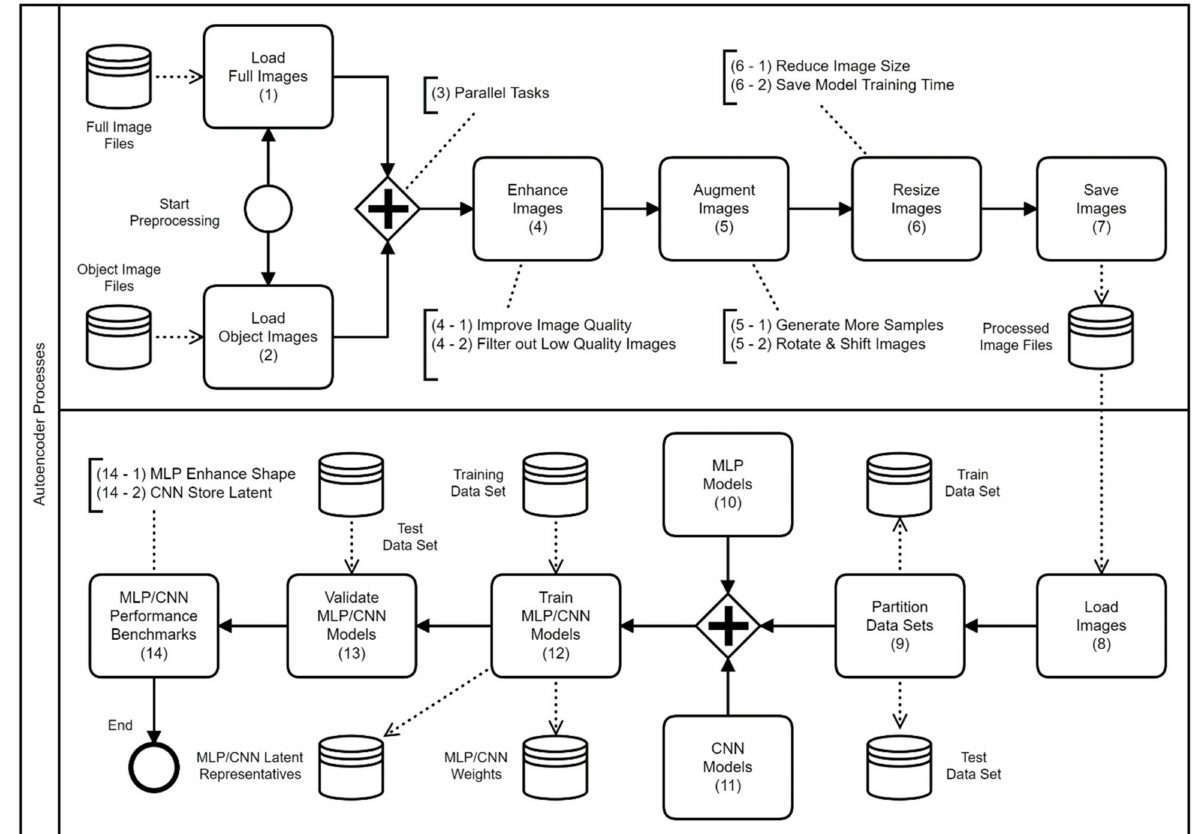
Figure 3. The proposed autoencoder